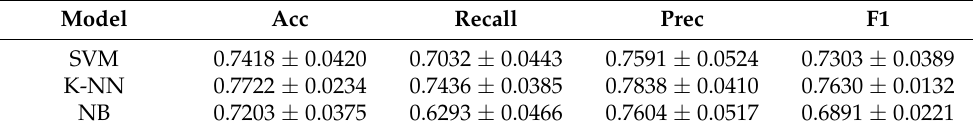
Table 4. Performance of previous machine learning models in the task of predicting food allergens.